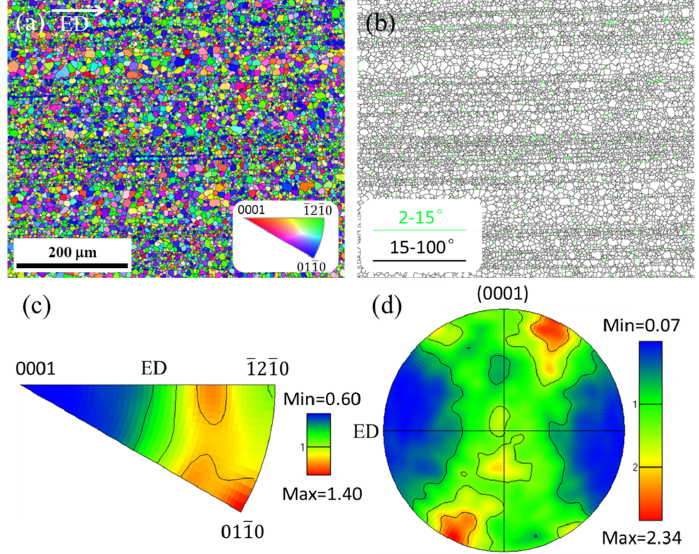
Figure 6. Inverse pole figure (IPF) map ( a ) of the as-extruded Ex-2 WE43 alloy along with its corresponding ( b ) boundary map, ( c ) typical IPF, and ( d ) (0001) basal pole figure (PF). The extrusion direction (ED) is horizontal in picture ( a ).